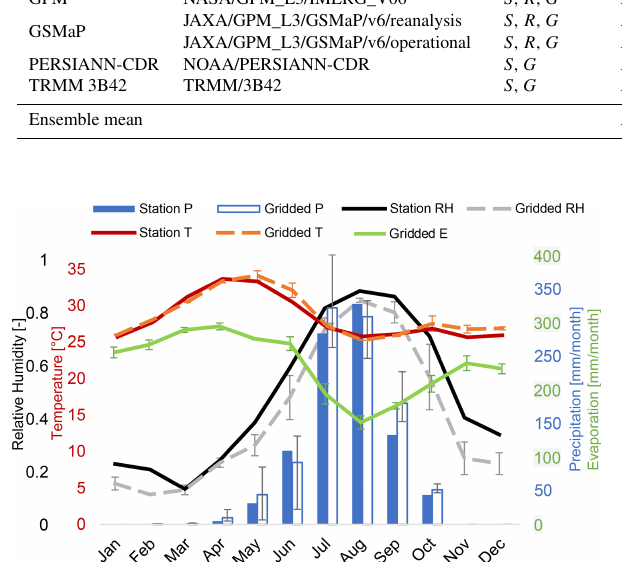
Figure 2. Climate diagram for Guioyo (located 25km northwest of Lac Wégnia) with data from the period March 2020–February 2021. “Station” refers to the TAHMO station data and “Gridded” refers to the ensemble mean of the gridded global datasets (Table 1). The error bars represent the full range of values among gridded